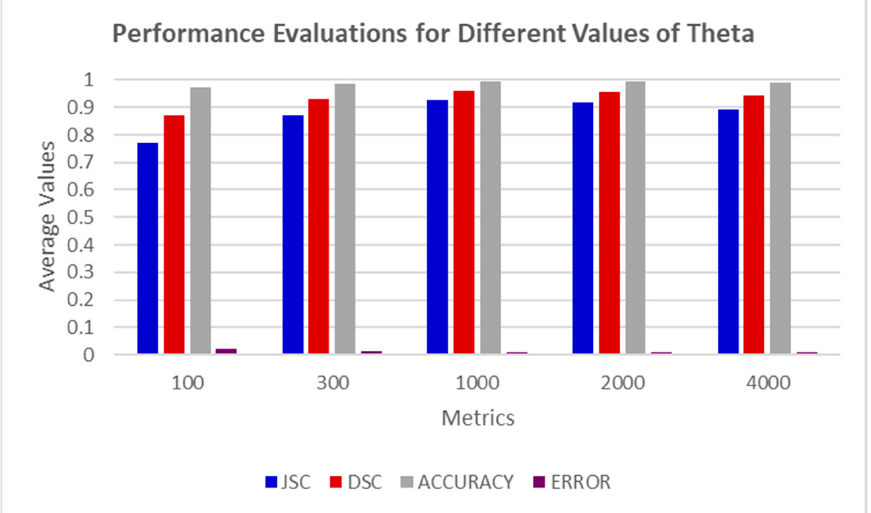
Figure 8. Performance Evaluations of the SSOMH Model with Different Values of θ .